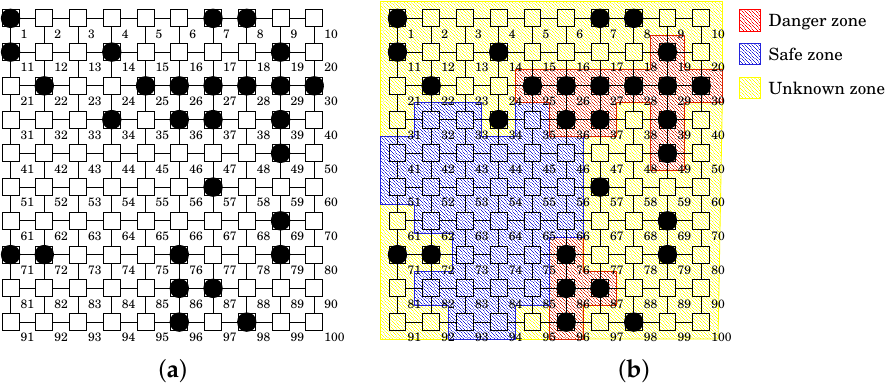
Figure 3. Application example of Procedure DBSCAN- BASED -Z ONING . ( a ) Mirai bots’ distribution. ( b ) Result of zoning.